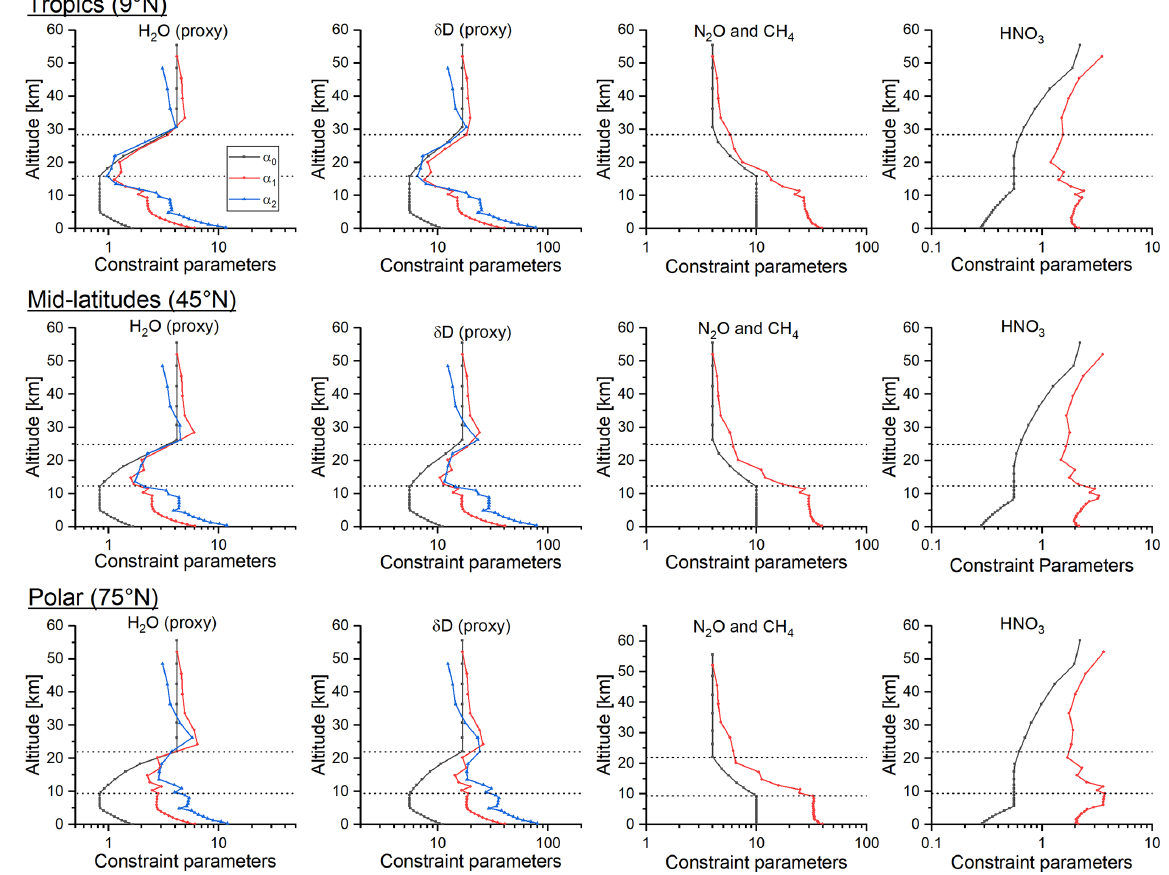
Figure 6. Vertical profiles of the constraint parameter (diagonal elements of the diagonal matrices α 0 , α 1 , and α 2 ) for the retrieval of all targeted atmospheric species (H 2 O, δ D, N 2 O, CH 4 , and HNO 3 ). The parameters are latitudinal and time dependent. Shown are examples for 8 July 2018 for the tropics (9 ◦ N), mid-latitudes (45 ◦ ), and polar regions (75 ◦ ). The area between the dotted lines indicates the transition between the troposphere and stratosphere.